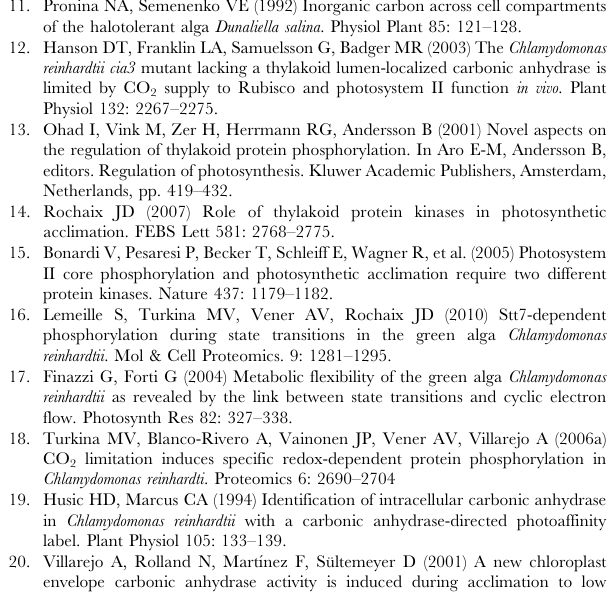
Figure S1 Association of Cah3 polypeptide with PSII core complexes from high- and low-CO 2 -grown C. reinhardtii cells. Immunoblot analysis of thylakoid membranes (Thy), BBY preparations (BBY), and PSII core complexes (Core) from cells of C. reinhardtii with antibodies raised against the over- expressed Cah3 polypeptide (Cah3) and D1 protein of PSII. The lanes were loaded with 10 m g